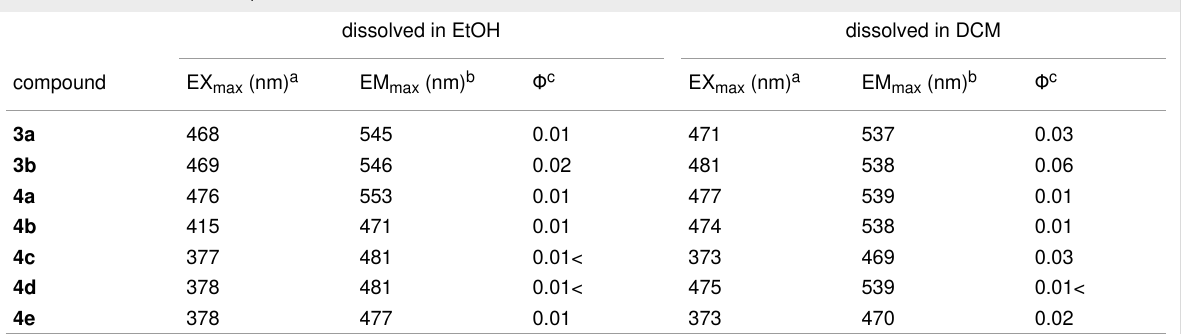
Table 2: Fluorescence data for products 3a , b , and 4a – e in EtOH and DCM.